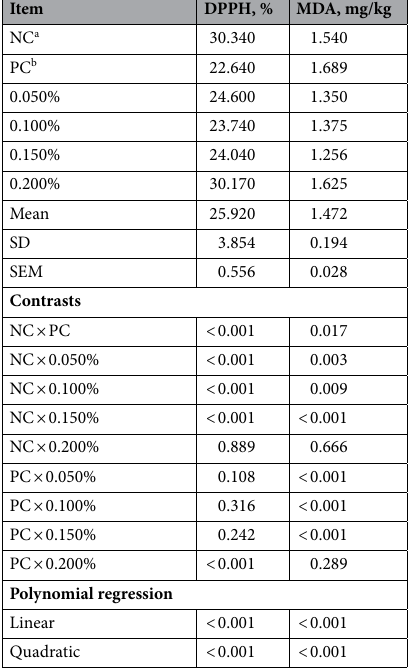
Table 4. Free radical scavenging assay (DPPH %) and malondialdehyde concentration (MDA) in the liver of 75–100 kg barrows fed diets containing different levels of inosine-5-monophosphate (5 ′ -IMP) and metabolizable energy (ME). a Negative control (0.00% 5 ′ -IMP and 3200 kcal ME/kg). b Positive control (0.00% 5 ′ -IMP and 3300 kcal ME/kg).